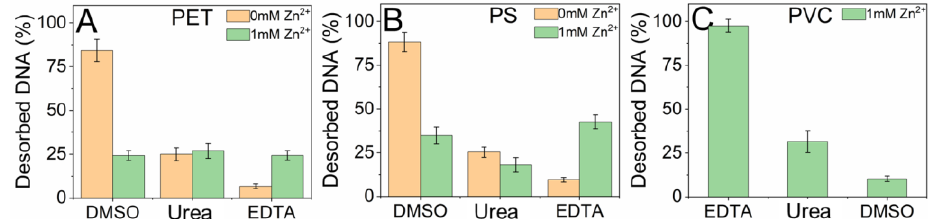
Figure 4. The desorption of salmon sperm dsDNA (~2000 bp) induced by DMSO (25%), 4 M urea, or 10 mM EDTA from the ( A ) PET, ( B ) PS, or ( C ) PVC microplastics. The pre-adsorption and desorption experiments were performed in a buffer (0 or 1 mM Zn 2+ , 10 mM HEPES, pH 7.6). For PVC, the desorption was studied after adsorption in the presence of 1 mM Zn 2+ . When DNA was adsorbed in the presence of 1 mM Zn 2+ , the desorption induced by When EDTA was added, dsDNA was almost fully desorbed (Figure 4C), suggesting that DMSO remarkably decreased to ~25% for PET and PS. In contrast, more DNA was de- metal-mediated interactions are vital for dsDNA adsorption on PVC. These data agreed sorbed by EDTA (up to 30%). It was suggested that in the presence of Zn 2+ , the role of with the adsorption experiments, where dsDNA did not adsorb on PVC in the absence of Zn 2+ (Figure 3C, black curve). Moreover, for different microplastics, the comparison of EDTA-induced desorption at the same Zn 2+ concentration (1 mM) suggested that the dsDNA adsorption affinity followed the order of PET > PS > PVC. atively charged DNA would be more electrostatically favorable.